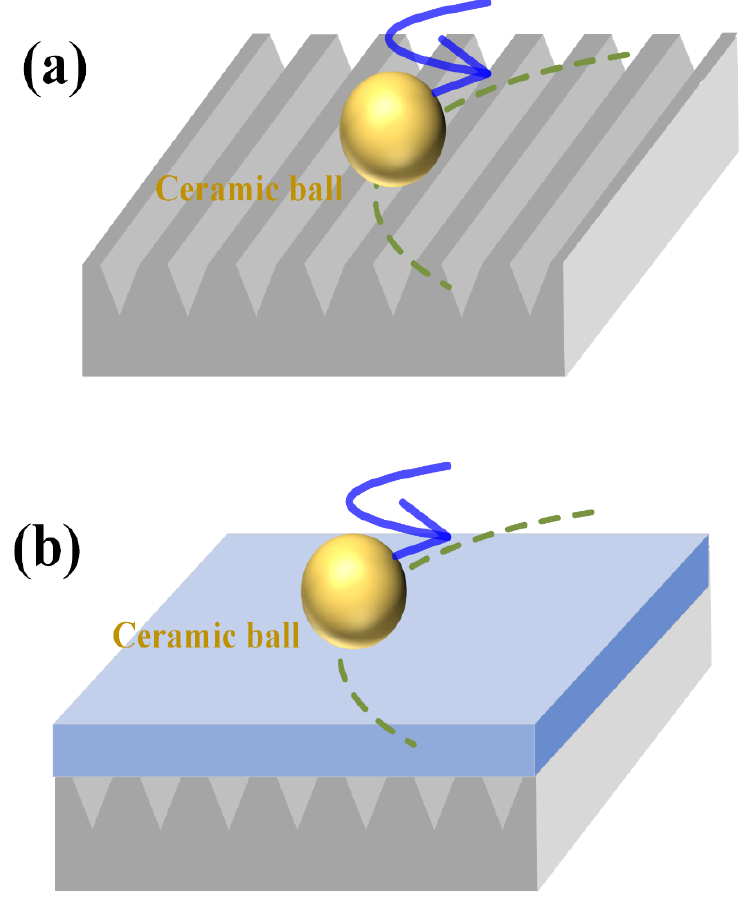
Figure 9. Schematic illustration of wear mechanisms for ( a ) dry sliding and ( b ) water lubrication.